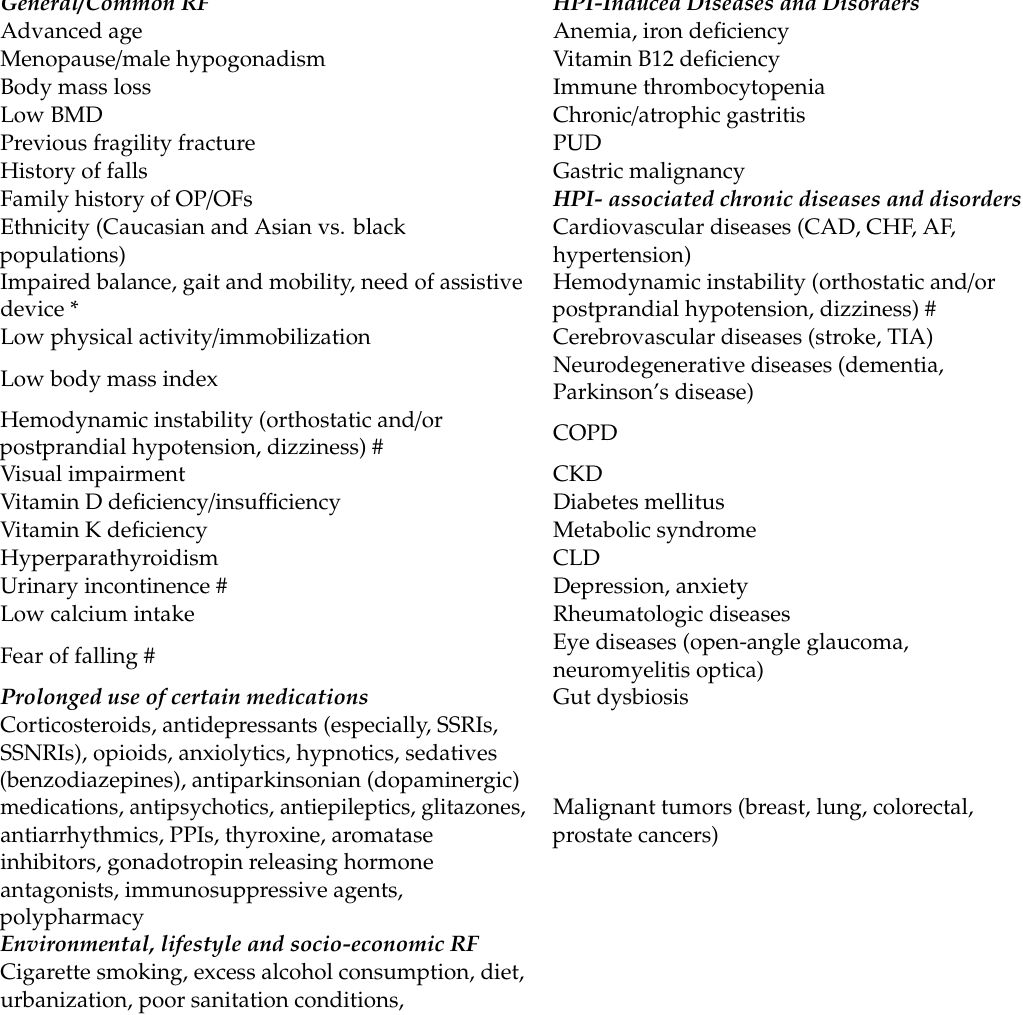
Table 3. Risk factors (RF) for osteoporotic fracture in patients with Helicobacter pylori infection. General / Common